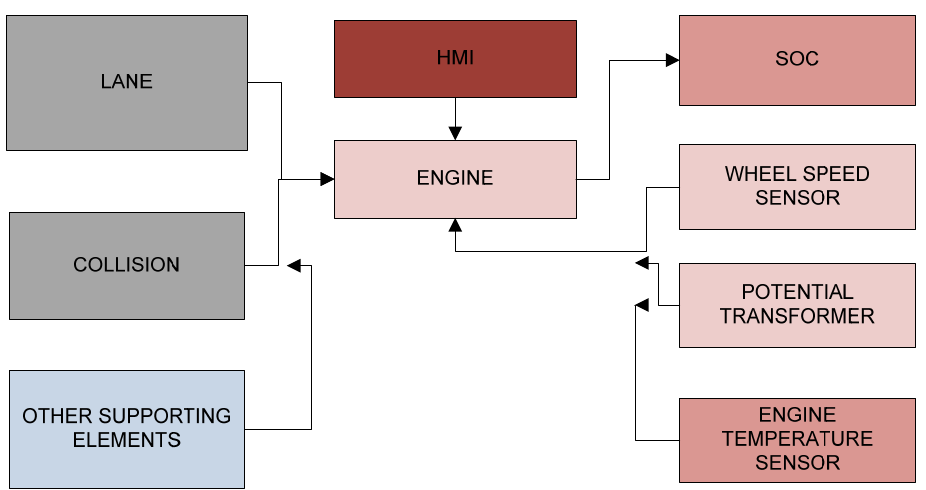
Figure 2. Block diagram of proposed advanced driver assistance system.